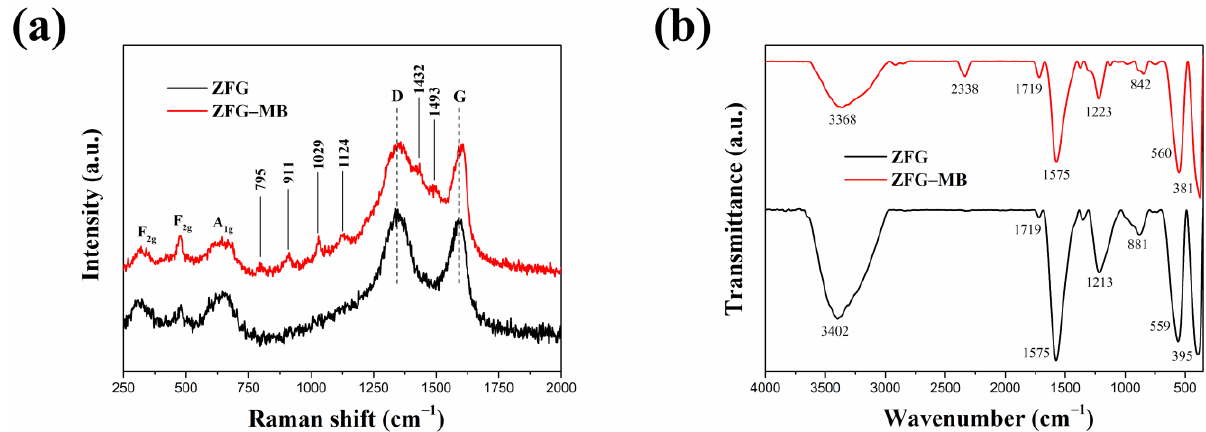
Figure 10. ( a ) Raman and ( b ) FT-IR spectra of ZFG and ZFG-MB. The third part is the electron donor-acceptor interactions ( π – π conjugation) with rGO